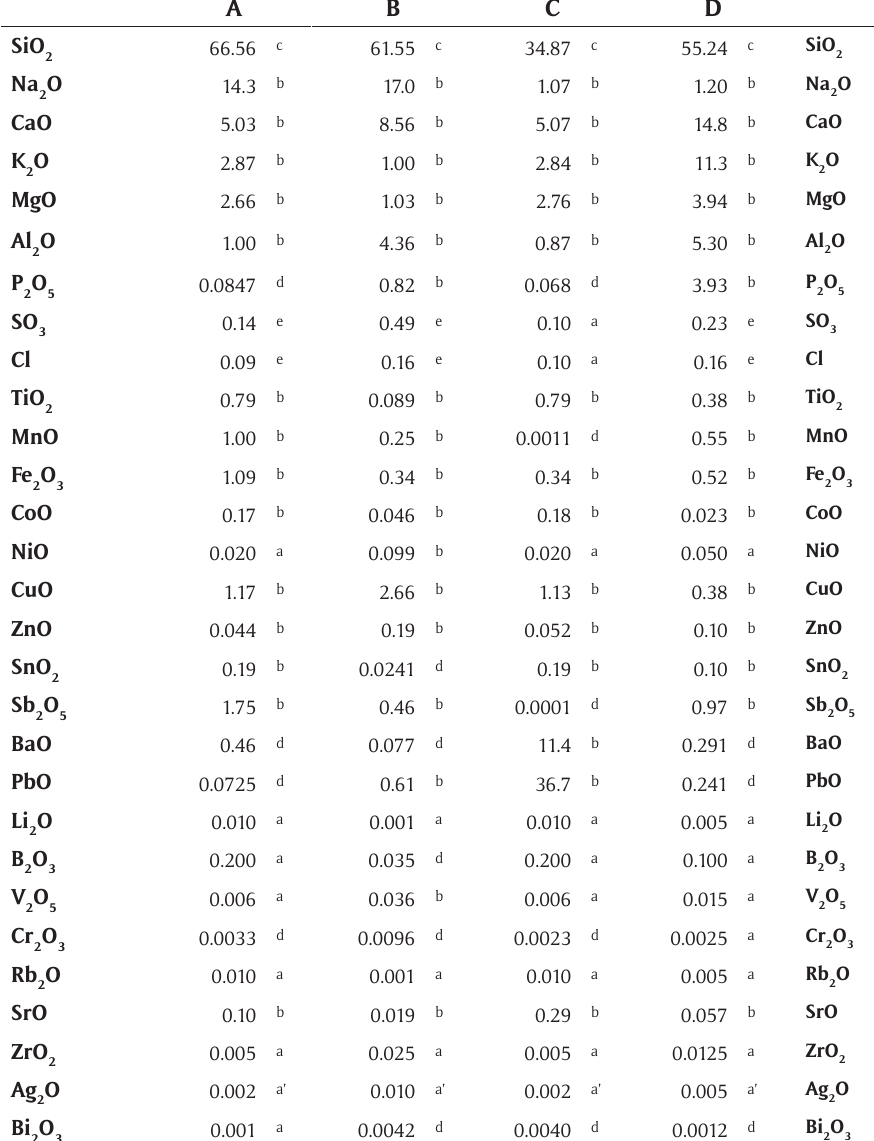
Table 3: Updated compositions for Corning Archaeological Reference Glasses A, B, C and D (wt%). a Brill 1972. Theoretical values, nominal compositions calculated from precursor mass fractions (uncontested by Wagner et al . 2012); a ’ Ag O concentrations were not addressed by Wagner and 2 colleagues. b Brill